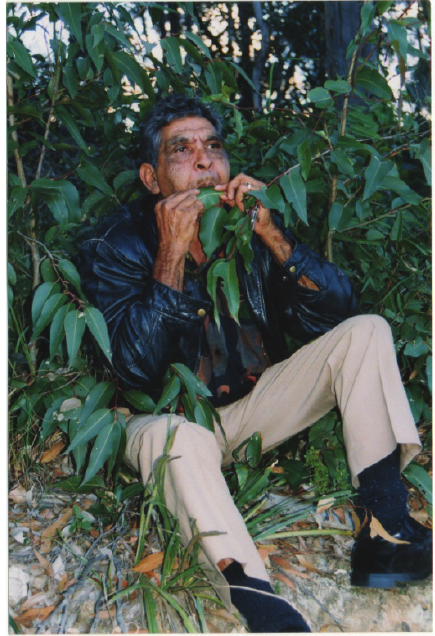
Figure 3. Herb Patten makes music in the bush off Glasshouse Rd, Narooma, NSW. Image Source: Christine Reid, May 1999. Published with permission from Narooma News /H.